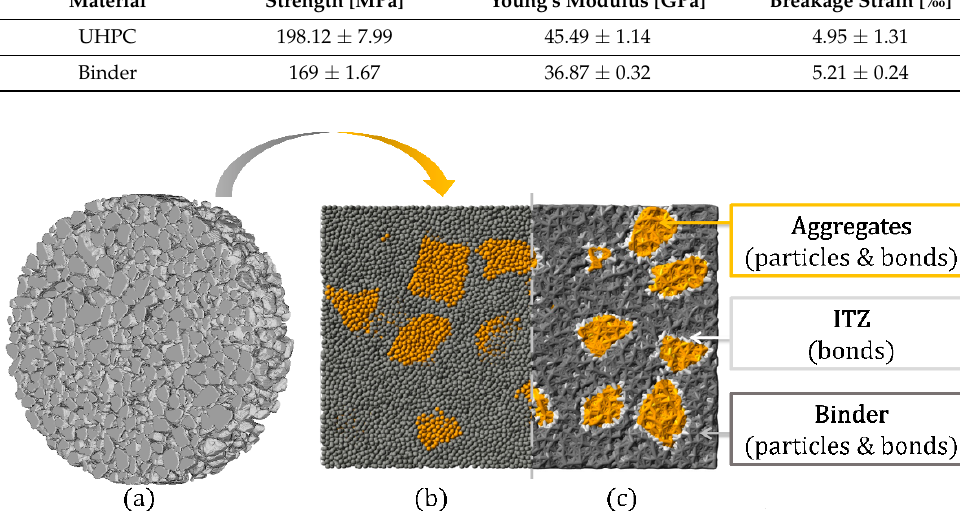
Figure 9. Cross-section detail of the structural three-phase UHPC model: ( a ) Reconstructed 3D models from µ CT of aggregate grains; ( b ) Particle view of binder and aggregate without bonds; ( c ) Cross-section showing all particles and bonds. Table 3. Simulation results obtained from uniaxial compression tests. Table 4. Main material parameters of the BPM model after calibration with static